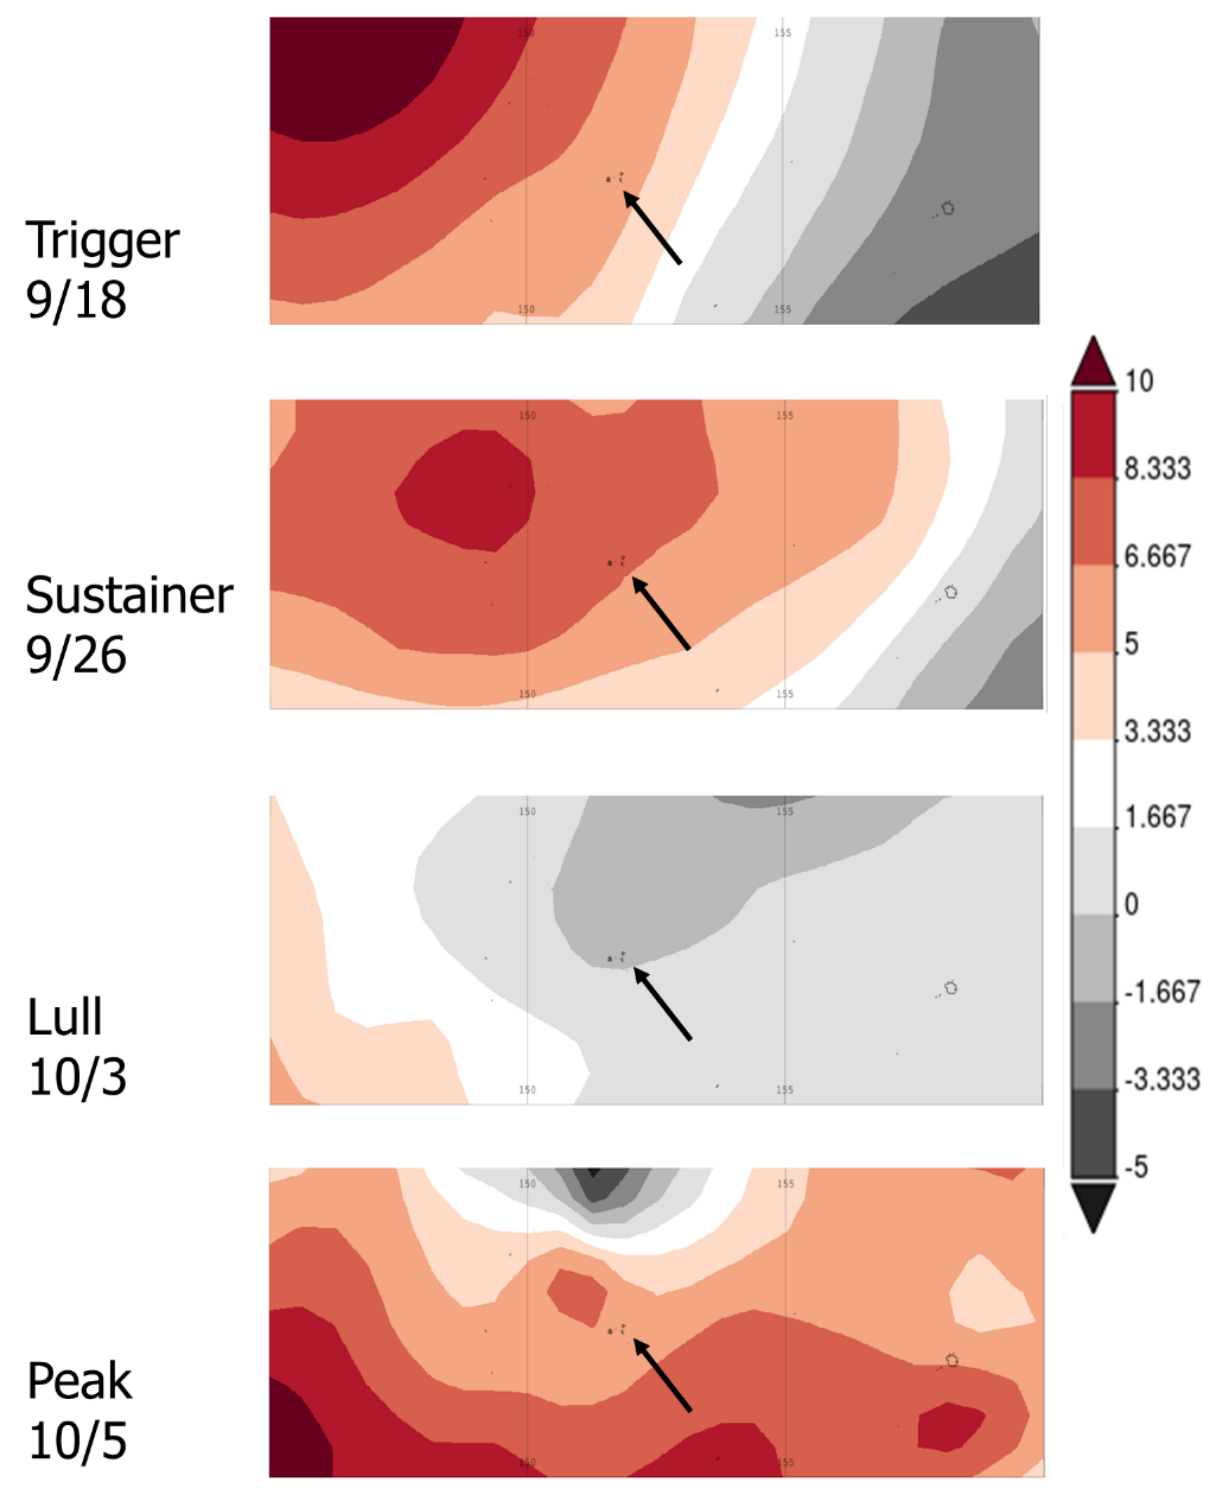
Figure 10. Time-averagedmaps of MERRA-2 instantaneous eastward wind for the four events of the wind sequence described for the October 2013 bloom event. The location of Chuuk Lagoon is indicated with the arrow. The region shown is 145–160 ◦ E, 5–10 ◦ N. Units are m/s.